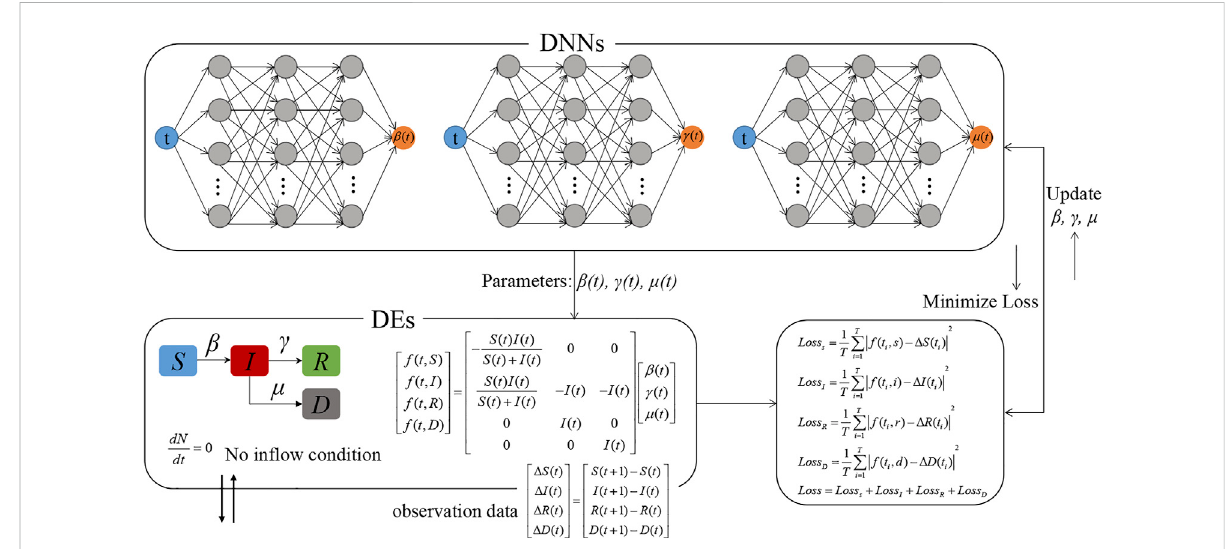
FIGURE 2 TheoverviewofEuler-PINNsforparametersestimation.Eachneuralnetworkscomprise5layers,theweightmatrix W k andthebiasvector b k